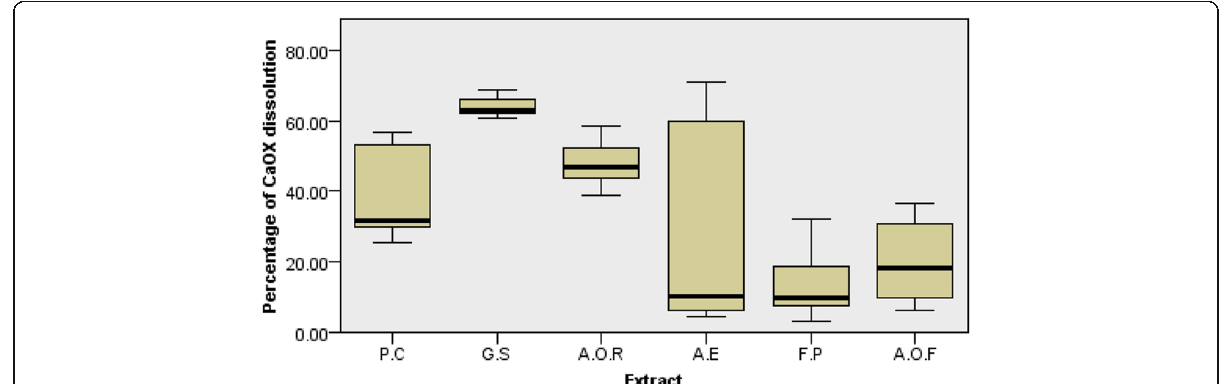
Fig. 1 Percent dissolution of oxalate calcium (CaOx) by different extracts. Petroselinum crispum (P.C), Gypsophila struthium (G.S), Alcea officinalis (Root) (A.O.R), Arnebia euchroma (A.E), Ferula persica (F.P) and Alcea officinalis (Flower)